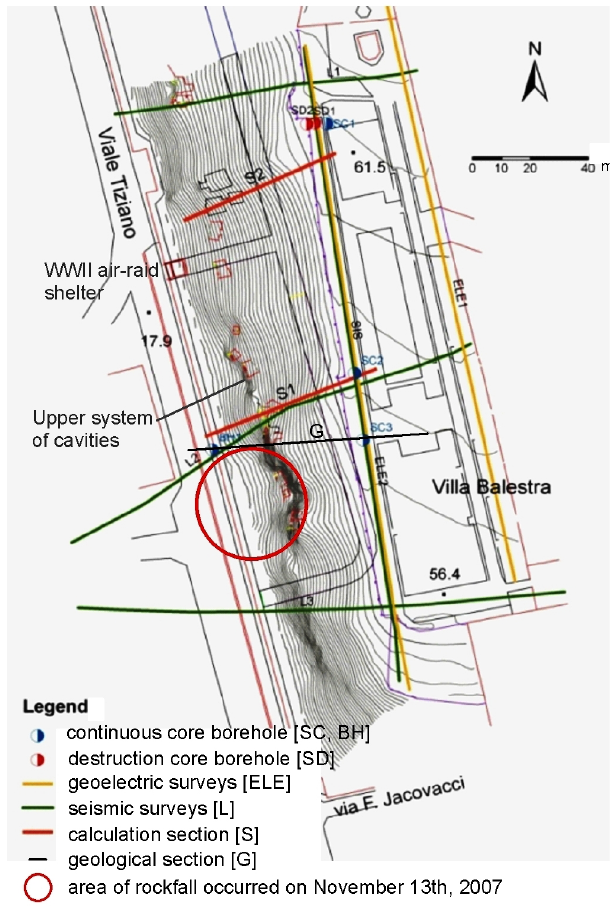
Fig. 4. Location of direct and indirect investigations.